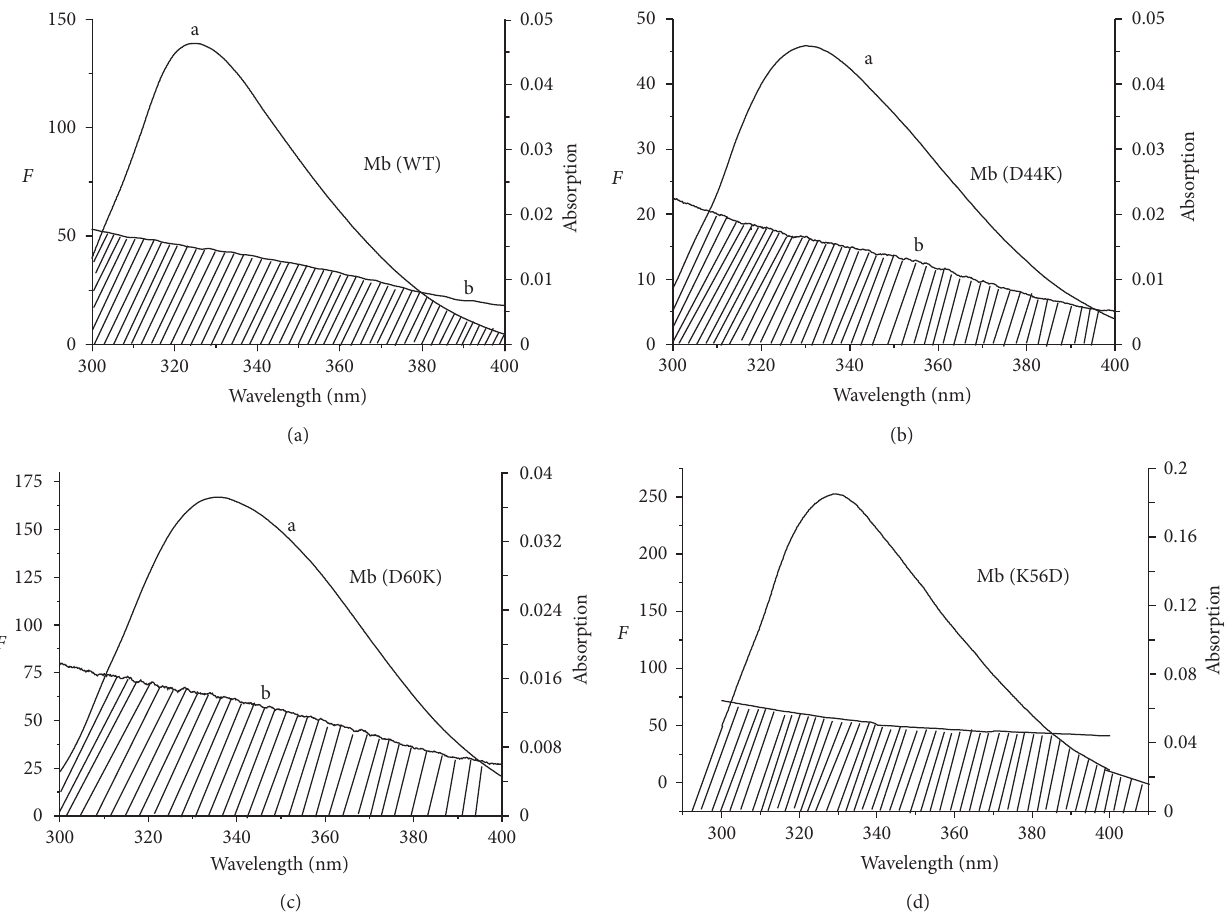
F 6: ��erlap of the �uorescence spectra of Mbs (a) and the absorption spectra of Fe(���) (b).